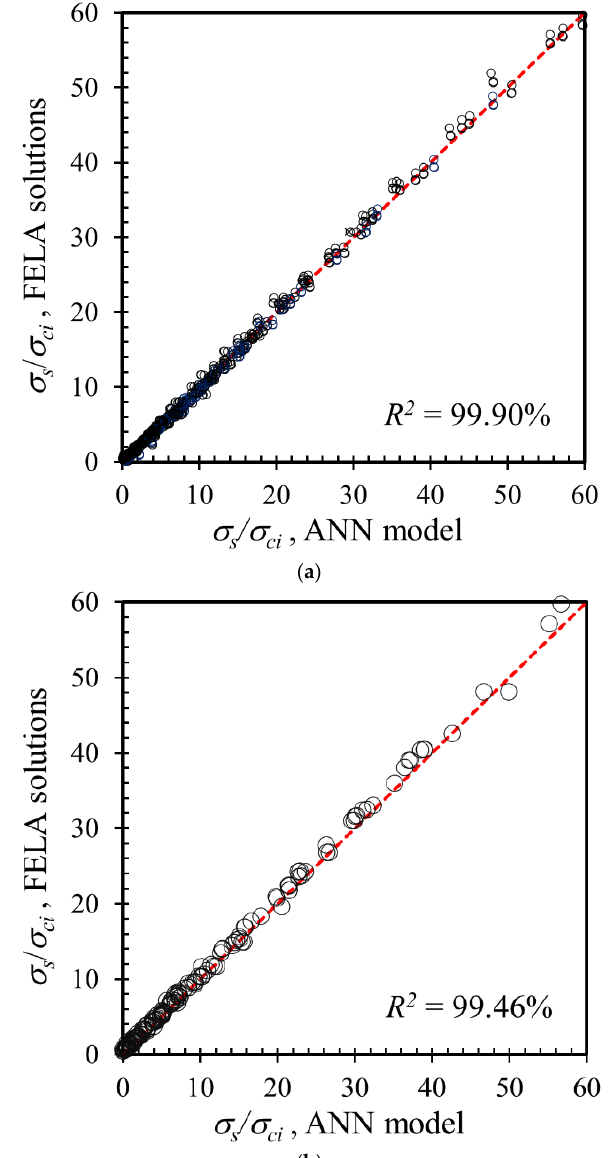
Figure 7. Comparison between the predictions of the FELA solutions and the proposed ANN model: ( a ) Training set; ( b ) Testing set. ( a ) Training set; ( b ) Testing